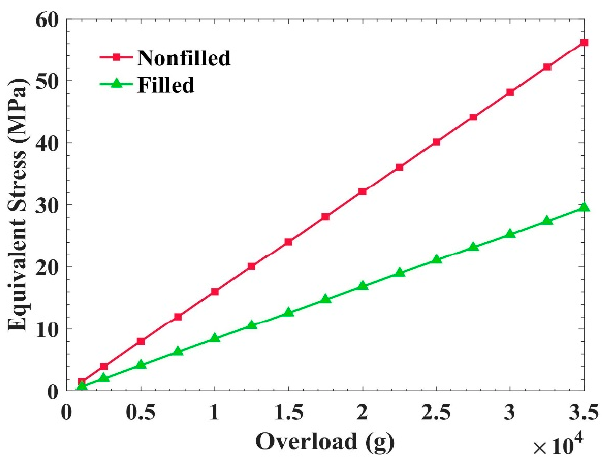
Figure 6. Stress changes in the PCB in the direction of vertical overload.